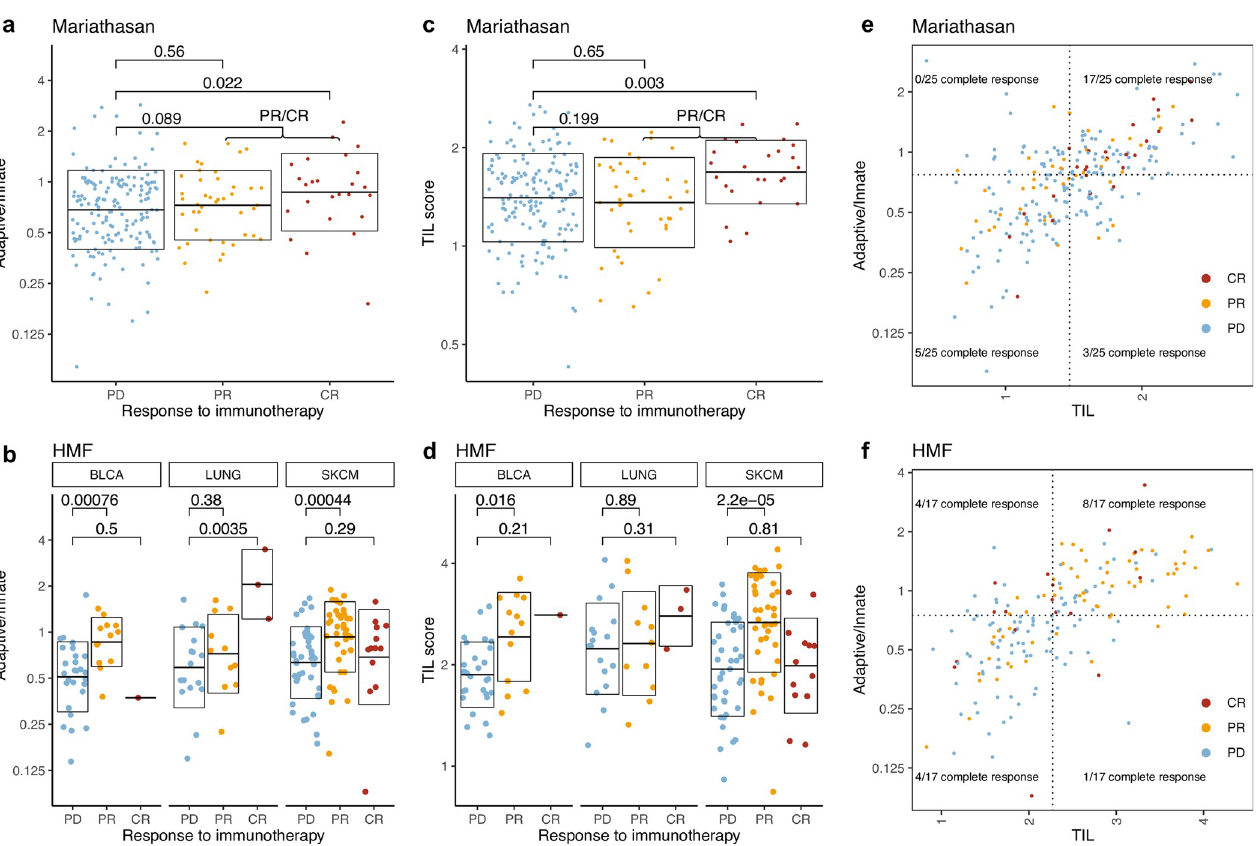
Fig 4. Response to immunotherapy. a) A/I ratio vs response to immunotherapy categories for the metastatic bladder cancer patients in the Mariathasan cohort. b) A/I ratio vs response to immunotherapy categories for the CPI treated metastatic cancer patients from the HMF cohort, for each of the three major cancer types. c) TIL score vs response to immunotherapy categories for the metastatic bladder cancer patients in the Mariathasan cohort. d) TIL score vs response to immunotherapy categories for the CPI treated metastatic cancer patients from the HMF cohort, for each of the three major cancer types. e) A/I ratio vs TIL score for metastatic bladder cancer patients in the Mariathasan cohort, colored by response category. 17/25 (68%) of patients with CR had both an A/I ratio and a TIL score above median (P = 0.0006). f) A/I ratio vs TIL score for the CPI treated metastatic cancer patients from the HMF cohort, colored by response category. 51/84 (61%) of all responders (CR and PR) there both have a high A/I ratio and a high TIL score (P =